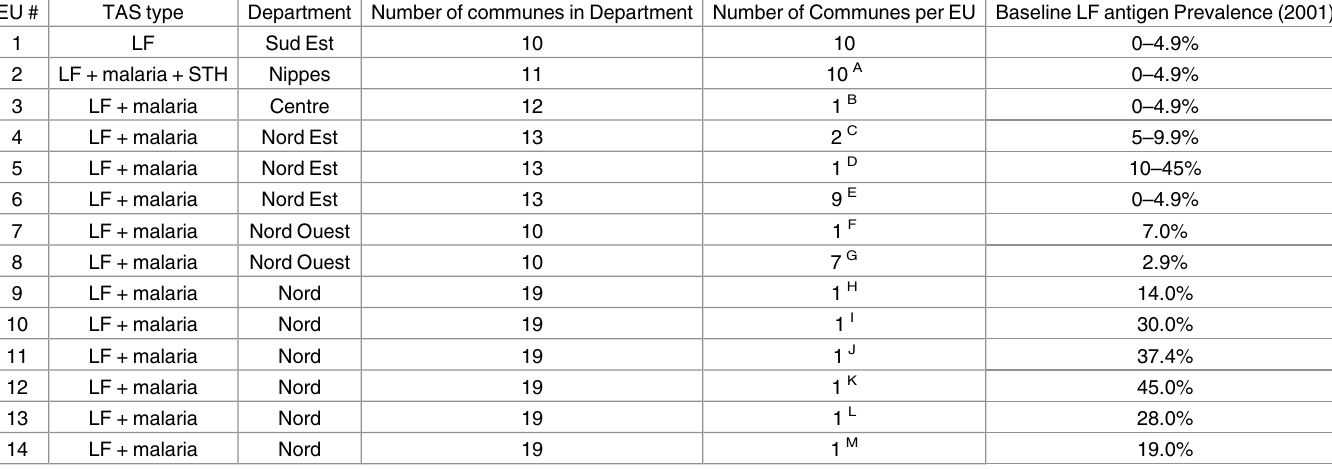
Table 1. Evaluation